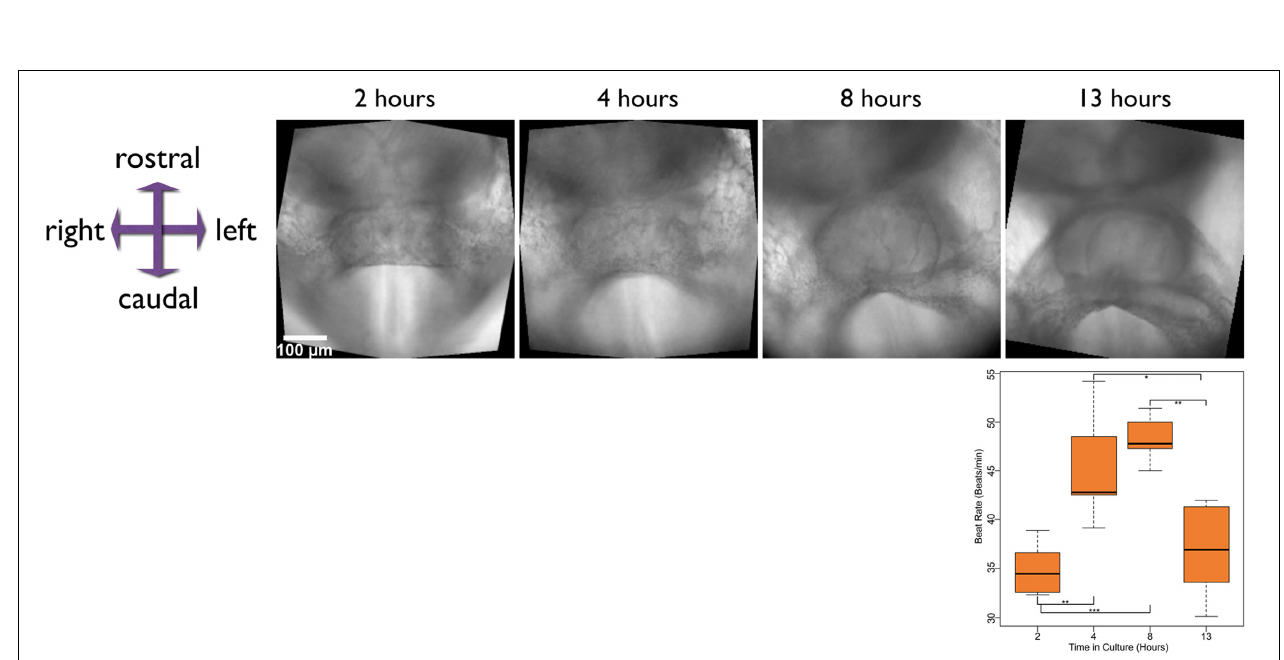
FIGURE 2 | Stills from time-lapse movies taken at various stages in the development of a late E7.5 embryo, developing from the cardiac crescent to linear heart tube stages. The time above each image is measured from the start of culture. Time-lapse movies were captured at each